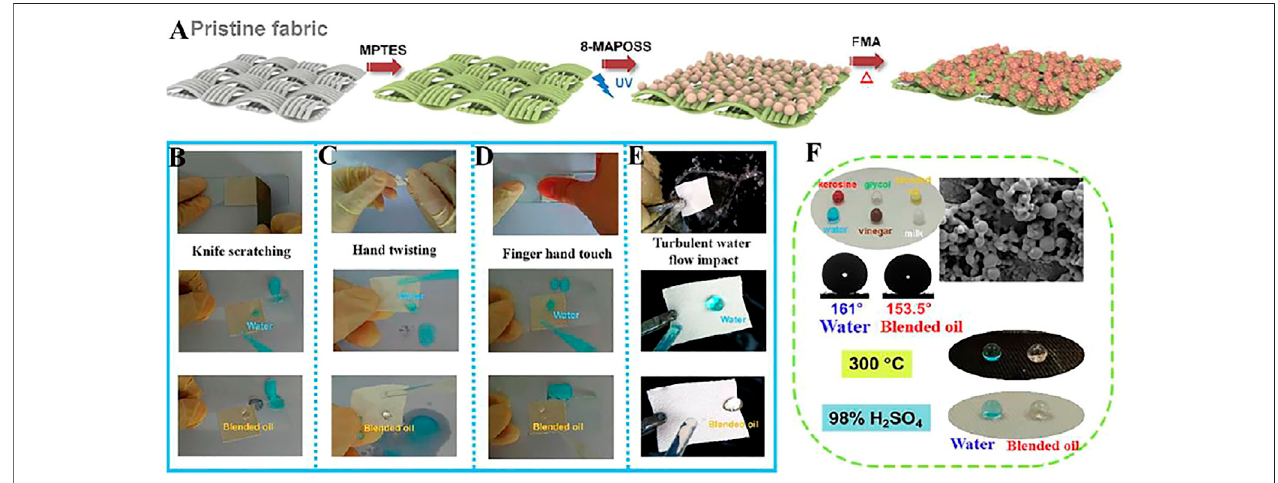
FIGURE 12 | (A) Schematic diagram of manufacturing process of Fabric-S-MAPOSS-F; Durability tests through (B) knife-scratching, (C) hand twisting, (D) fi nger hand touch, and (E) turbulent water fl ow impact. (F) Common droplets (kerisine, dyed with oil red dye; glycol, colorless; blended oil, yellow; water; vinegar, brown; milk, lacte) on fabric, and liquid repellency of Fabric-S-MAPOSS-F after immersion in 98% H 2 SO 4 for 30 min and 300 ° C heating for 2 h (Luo et al., 2020).